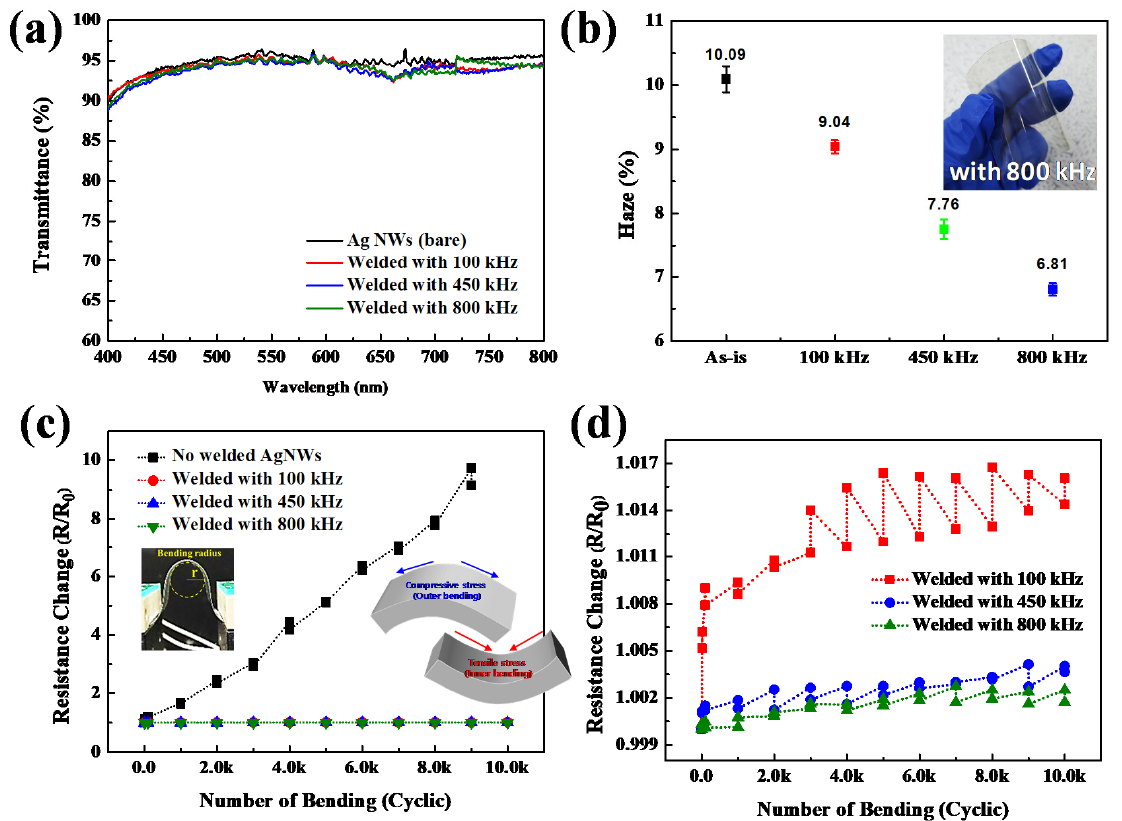
Figure 6. ( a ) Optical transmittance, ( b ) haze, and ( c , d ) resistance change with bending cycles of the Ag NW networks on PEN that were not, and were welded at 100, 450, and 800 kHz frequency at 6 kW for 60 s.